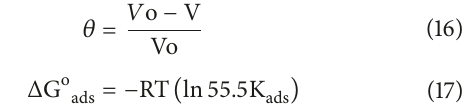
surface coverage 𝜃 at different inhibitor concentration. Cal-